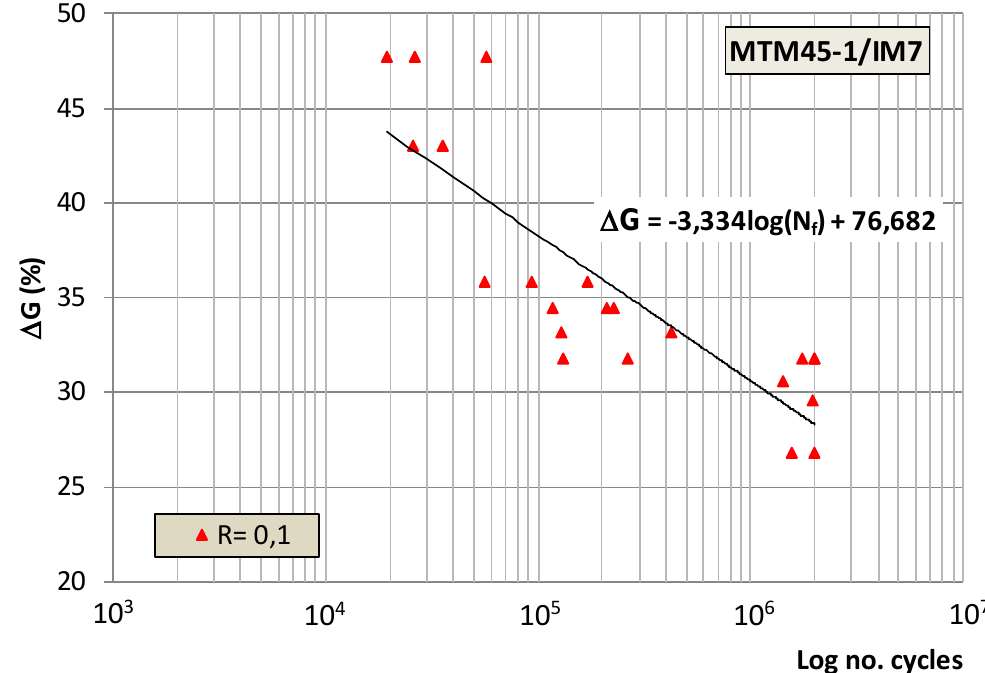
Figure 4. Fatigue loading levels expressed as a percentage of the static energy release rate.